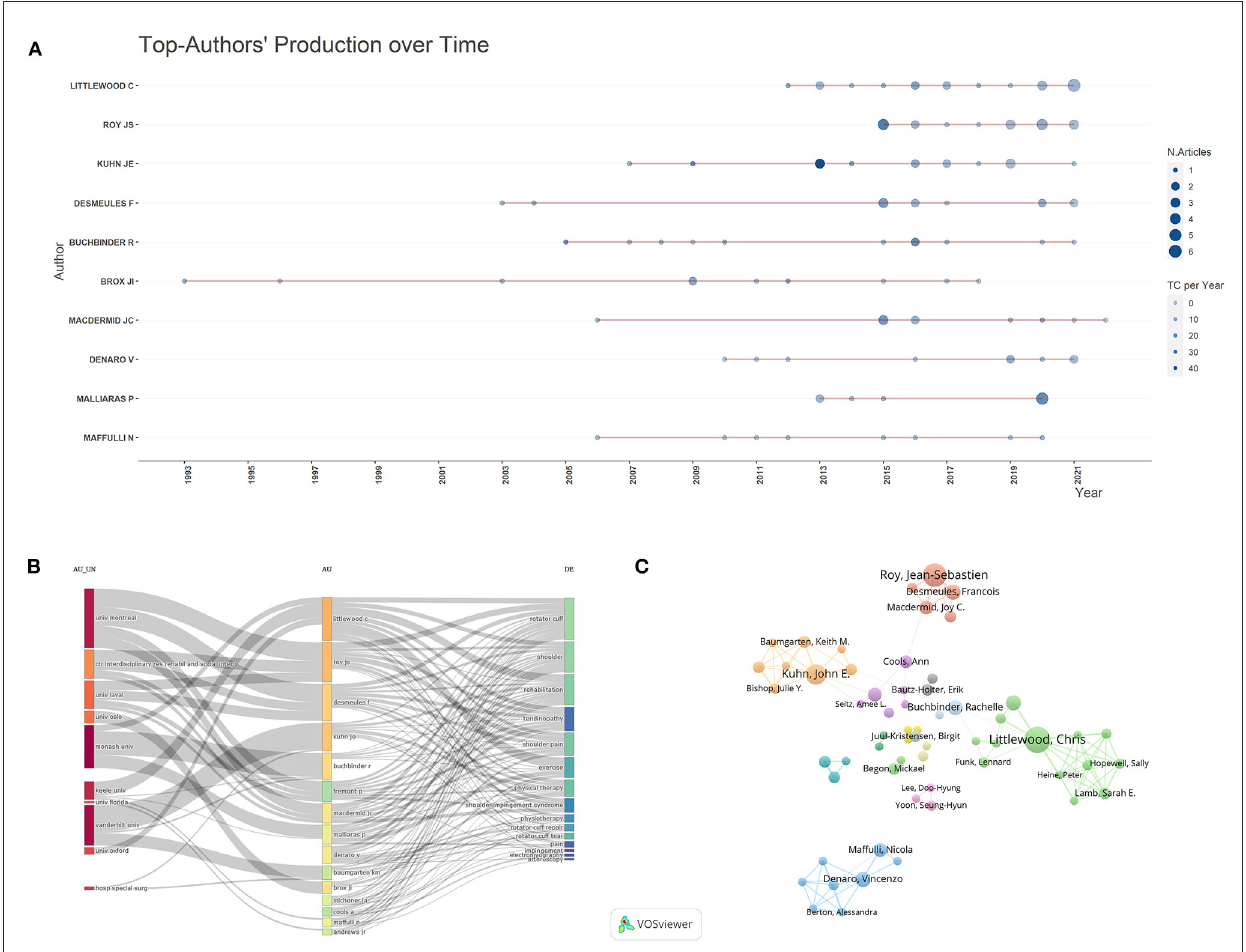
FIGURE6 The top 10 authors and cooperative network on rehabilitation of rotator cuff injury. (A) The top-10 authors’ production over time. (B) The three-dimensional plots over the authors, affiliations and research directions. (C) The co-network visualized map of authors.